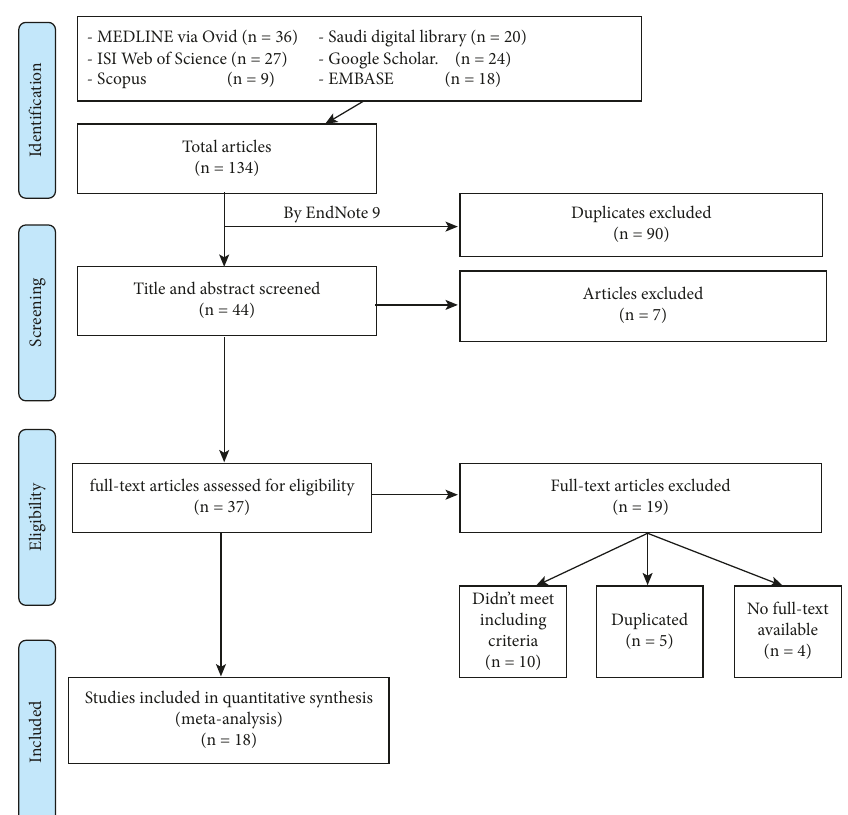
Figure 1: Flowchart illustrates a summary of the literature review and research selection